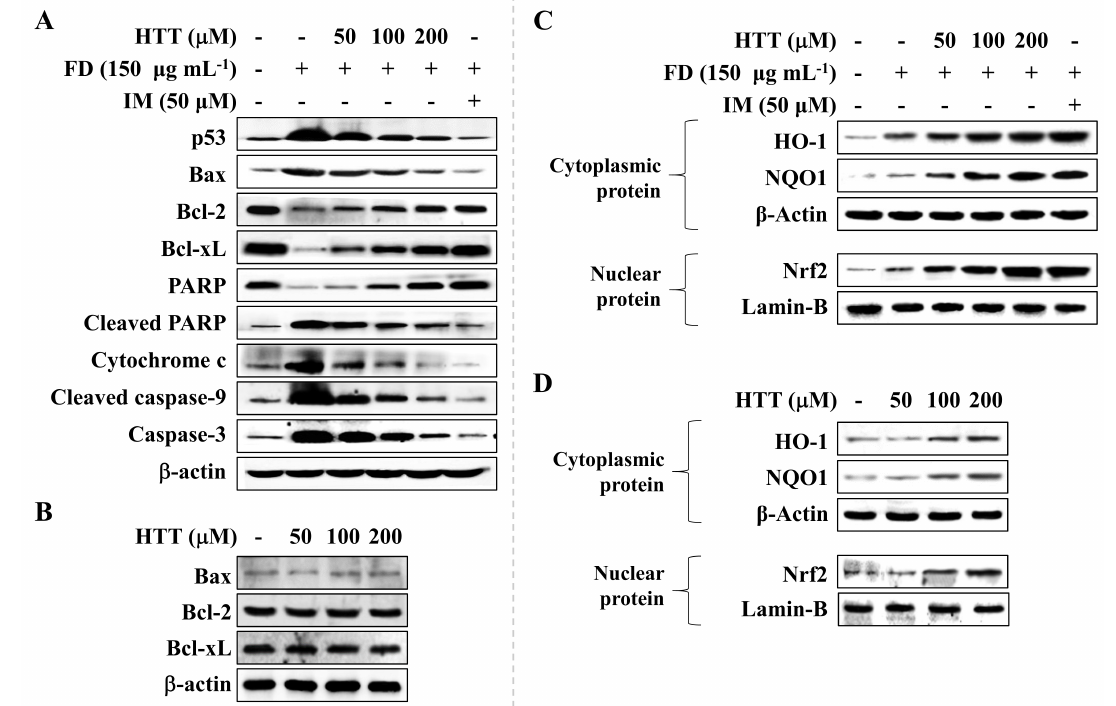
Figure 4. E ff ect of (–)-loliolide (HTT) on the levels of key apoptosis and antioxidant molecular mediators. E ff ect of HTT on key apoptotic mediators in ( A ) fine dust (FD)-induced and ( B ) non-induced cells. E ff ect of HTT on nuclear factor E2-related factor 2 (Nrf2) / heme oxygenase-1 (HO-1) signaling molecules in ( C ) FD-induced and ( D ) non-induced HaCaT cells. Seeded cells were treated with di ff erent concentrations of HTT one hour before stimulation. Indomethacin (IM) was used as the positive control. The experiment was done in three independent trials to confirm